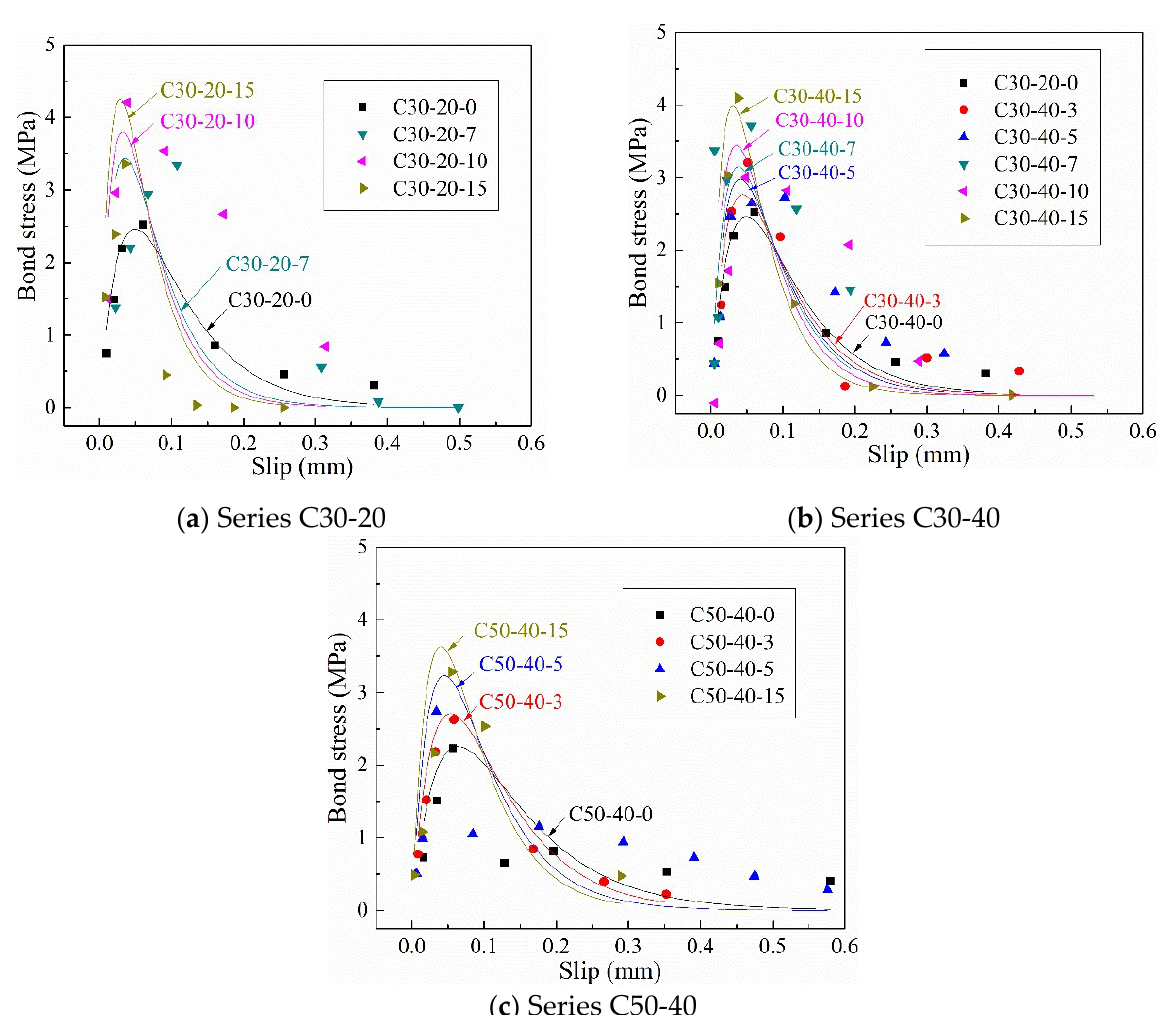
Figure 10. Comparison between the proposed bond stress-slip model and experimental results.